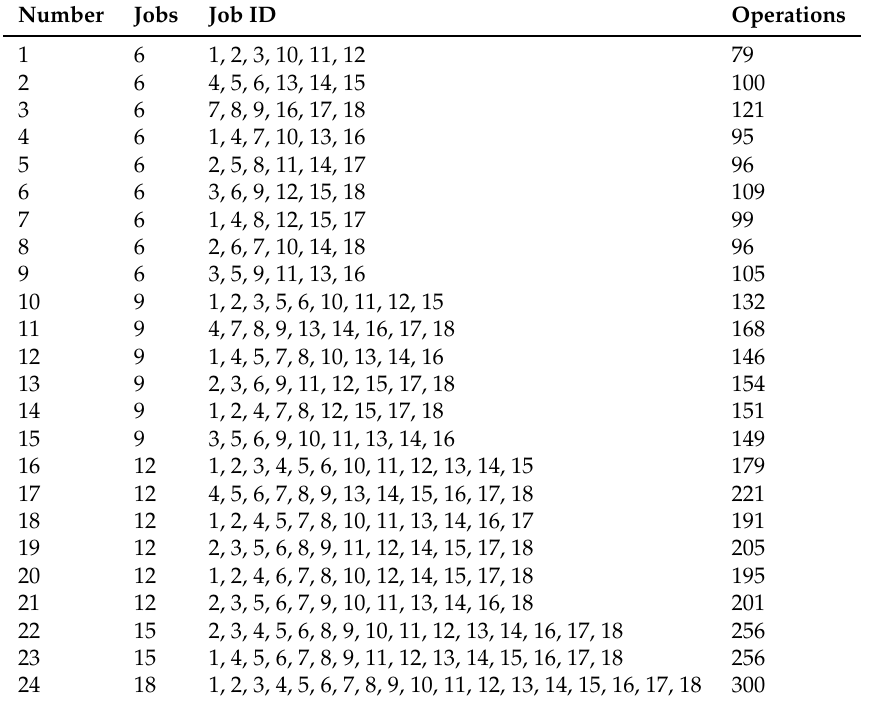
Table 2. Instances in Kim’s benchmark.